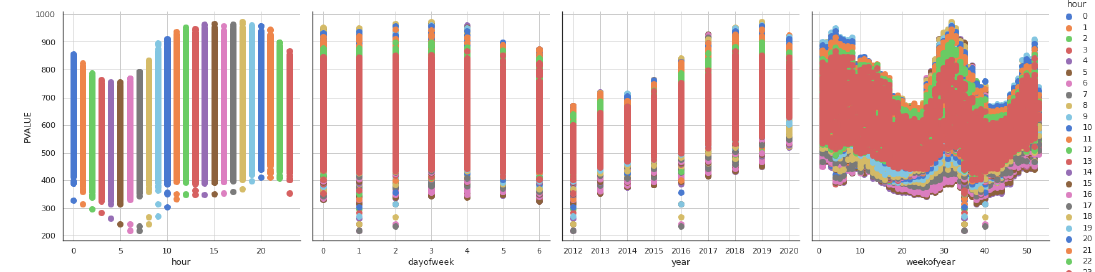
Figure 5. Power use in MW by hour, day of week, year, and week of year.